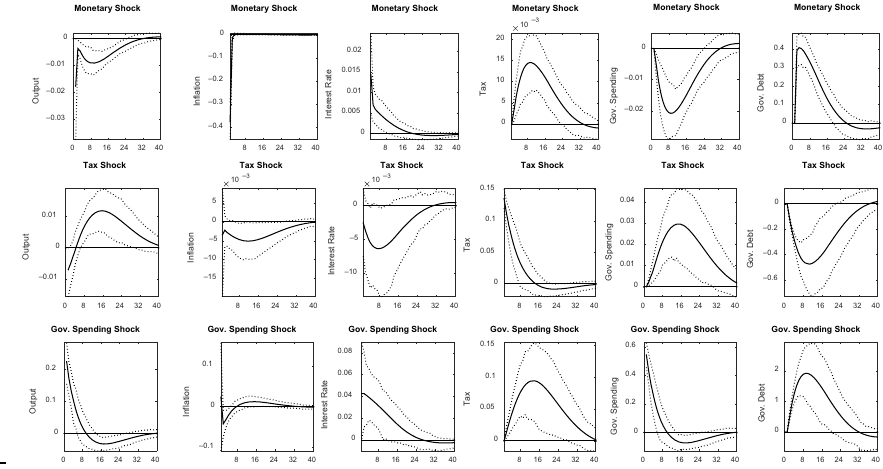
Figure 1. IRF to policy